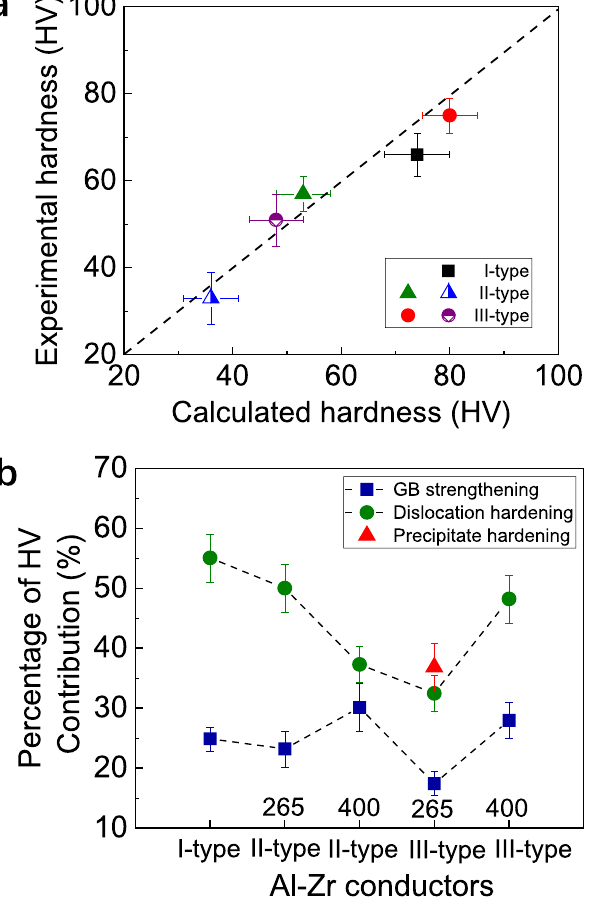
Figure 8. Calculations on the strengthening contributions. ( a ) Calculation on the total hardness of the Al-Zr conductors, in comparison with the experimental results. ( b ) The respective contribution of dislocation hardening, grain boundary strengthening, and precipitate hardening to the total hardness (in percentage, %) based on the